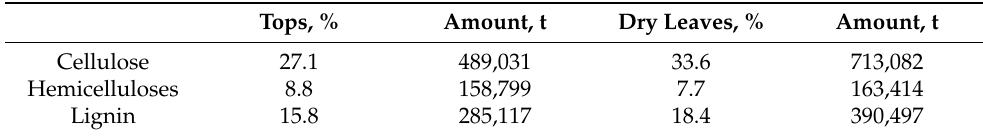
Table 12. Composition and amount of trash in regard to lignocellulosic materials after hydrothermal